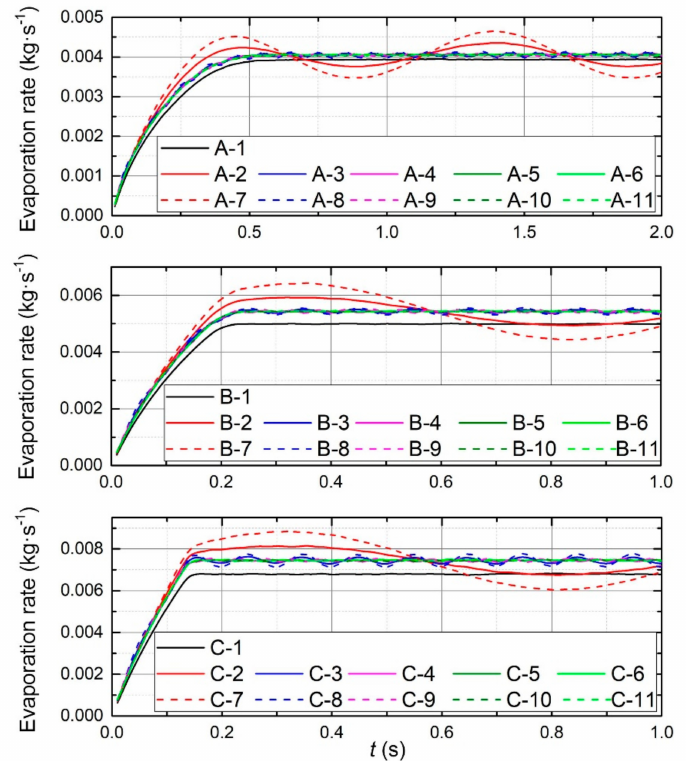
Figure 7. Time-dependent evaporation rates under di ff erent cases.